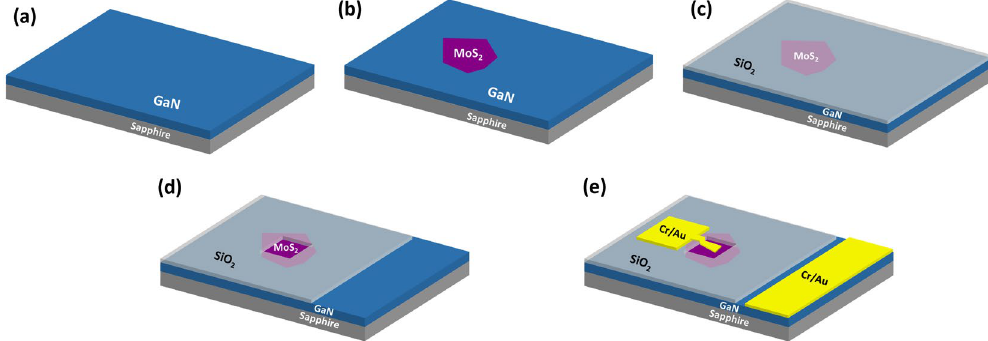
Figure 6. Process flow of the fabrication process. ( a ) GaN/Sapphire substrate. ( b ) Transfer of MoS 2 flakes on GaN/Sapphire substrate. ( c ) Deposition of SiO 2 on the template for insulation of electrodes. ( d ) Selective etching of SiO 2 over MoS 2 and GaN. ( e ) Electrode deposition on MoS 2 and Experimental Section The MOVPE grown Gallium Nitride (GaN) epitaxial film on c-plane sapphire substrate with 3 μ m thickness has been used for MoS 2 /GaN heterojunction. The GaN layer exhibits n-type behavior, sheet resistance of about 285 Ω/square, carrier concentration of 4.6 × 10 17 cm − 3 and Hall electron mobility of about 160 cm 2 /Vs at room tem- perature, as measured by Ecopia Hall measurement set up (HMS 5000). The samples were ultrasonically cleaned in acetone followed by iso-propanol and De-ionized water (DI-Water) for 5 minutes each, to remove the organic contaminants. In order to etch the native oxide layer from the surface, samples were dipped in the solution of HCl: H 2 O in the ratio of 1:2 for 30 s. Samples were again rinsed with DI water and thereafter dried with nitrogen gun. MoS 2 crystal was purchased from SPI supplies. For the fabrication of MoS 2 -GaN heterojunction, 2D MoS 2 flakes were transferred on GaN/sapphire from MoS 2 crystal using mechanical exfoliation method (Fig. 6a,b). Raman measurement was conducted to confirm the MoS 2 flake using micro- Raman system (Horiba LabRAM HR evolution) with laser excitation wavelength of 514 nm. KPFM measurements were performed using Bruker multi mode Atomic Force Microscope in tapping mode. Pt coated Si tip was used to scan the samples and samples were grounded during the measurements. After transfer of MoS 2 on GaN, SiO 2 of thickness 100 nm was deposited on MoS 2 /GaN sample using sput- tering as an insulating layer (Fig. 6c). PMMA resist was spin coated on the template. Windows were opened on top of MoS 2 (8 μ m × 8 μ m) and GaN (40 μ m × 40 μ m) using Electron beam lithography (Model No: eLine plus from Raith GmbH). SiO 2 was etched away within the opened window by dipping the sample in 10% HF for 10 seconds (Fig. 6d). After removing the remaining resist in acetone, again electron beam lithography was used electrode on GaN (Fig. 6e). Current-voltage characteristics of the device were measured using DC probe station (EverBeing-EB6) and Semiconductor Characterization System (Keithley: SCS-4200) under dark and illuminated